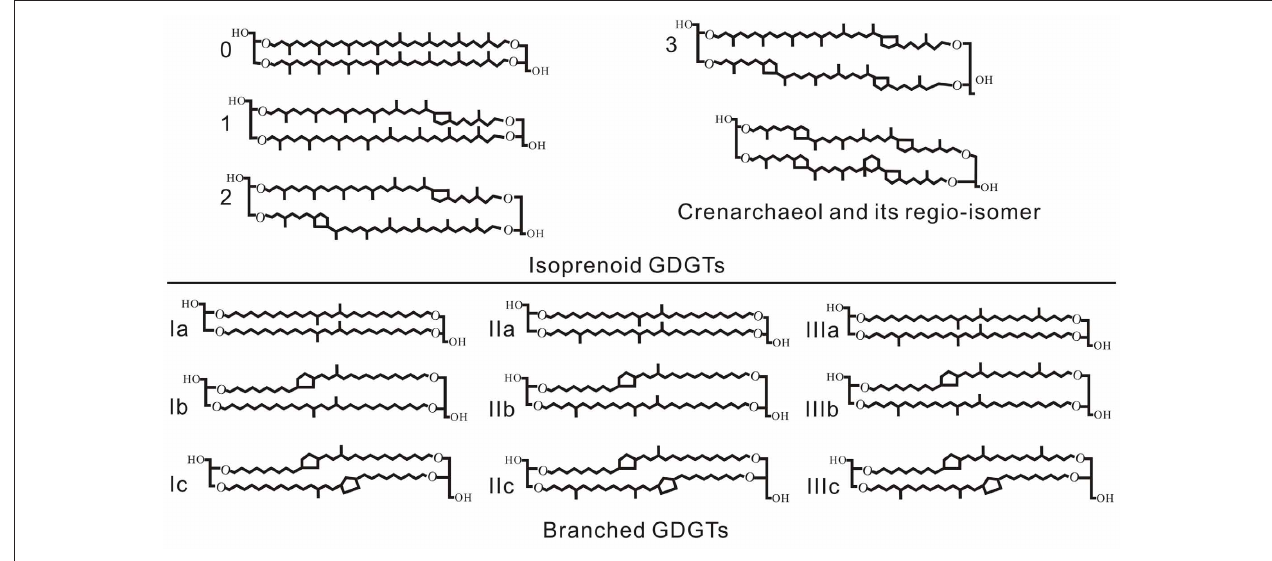
FIGURE 1 | Molecular structures of isoprenoid GDGTs and branched